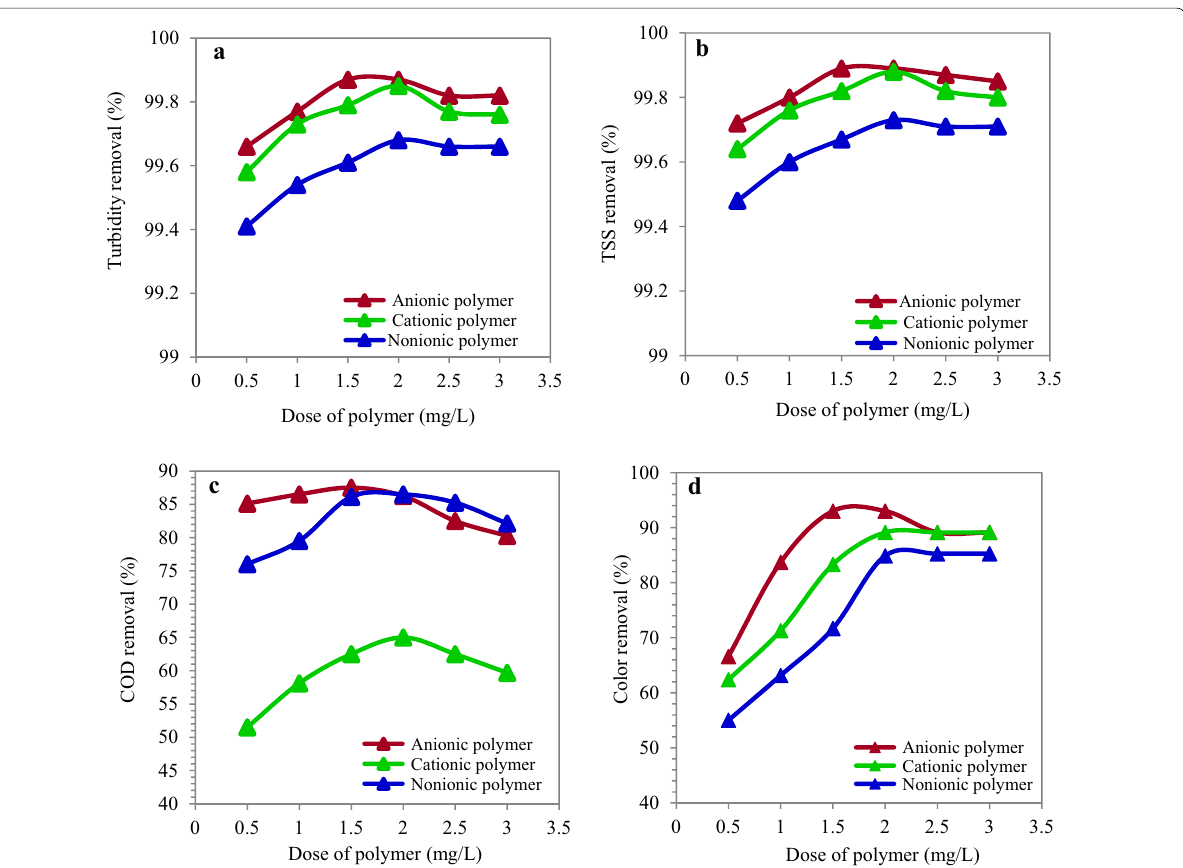
Fig. 5 Turbidity ( a ), TSS ( b ), COD ( c ) and color ( d ) removal efficiency in different dose of anionic, cationic and nonionic polymers (At pH PAC 300 =